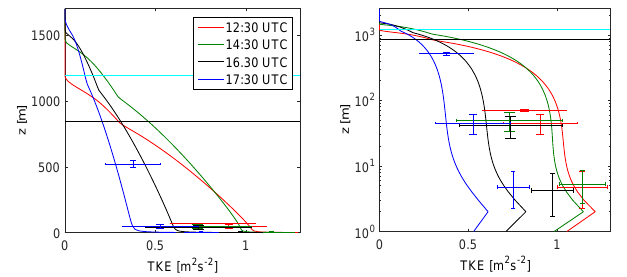
Figure 7. Profiles of TKE during the afternoon period on 20 June. The color scheme is the same as in earlier figures. The measure- ments on both the small tower (2–8m) and the taller 60m tower (30–60m) were averaged and are shown with ± 1 standard devia- tion. The data at times 14:30 and 16:30UTC were displaced slightly in height to more easily see all error bars. The vertical error bar de- note upper and lower height limits of data. Also included (at 12:30 and 17:30UTC) is TKE from a tethered balloon-borne 3-D sonic operating at about 70 and 520m,